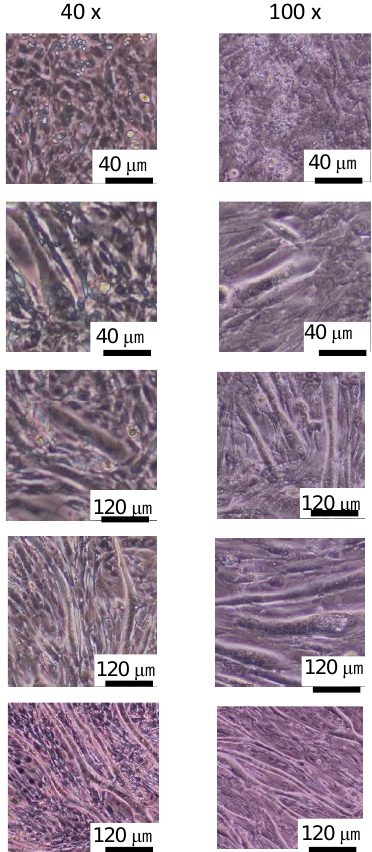
Figure 4. Microscopic images of C2C12 cells during myogenic differentiation culture.